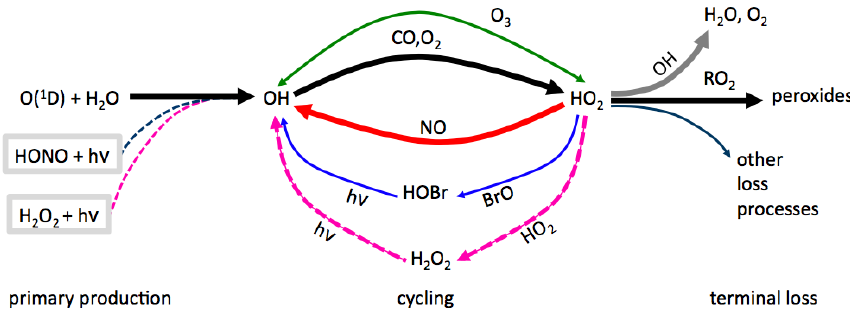
Fig. 13. Scheme of the major OH sources, HO x interconversion reactions, and HO 2 loss processes shown in Fig. 12. The large arrows indicate the most important processes in the model at Summit during the focus period. The gray boxes indicate primary OH sources that may be due to snow emissions. H 2 O 2 may contribute more to OH levels, as indicated by the dashed magenta